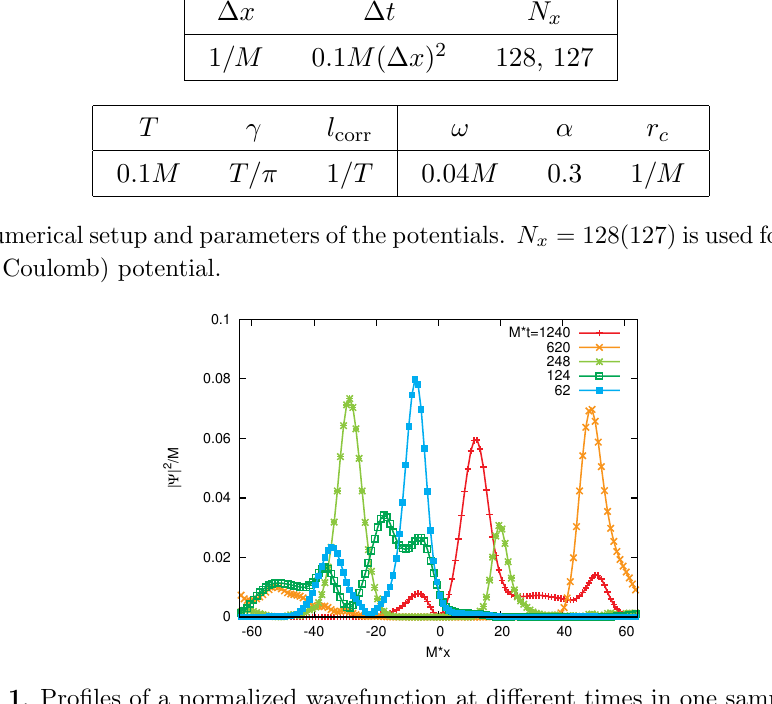
Figure 1 . Pro(cid:12)les of a normalized wavefunction at di(cid:11)erent times in one sample